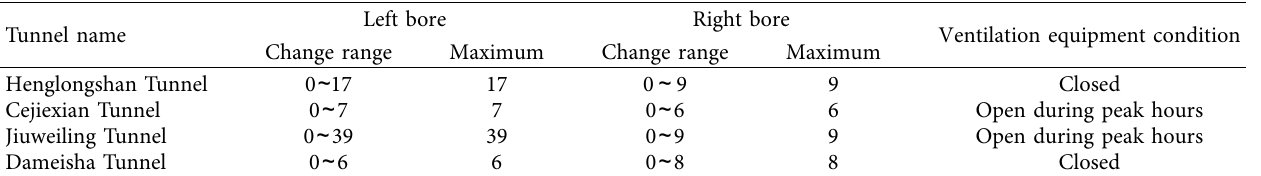
Figure 7: Diurnal profile of air velocity in the left bore of Cejiexian Tunnel (Apr 18, 2014). Table 4: CO concentrations in the four tunnels (unit: